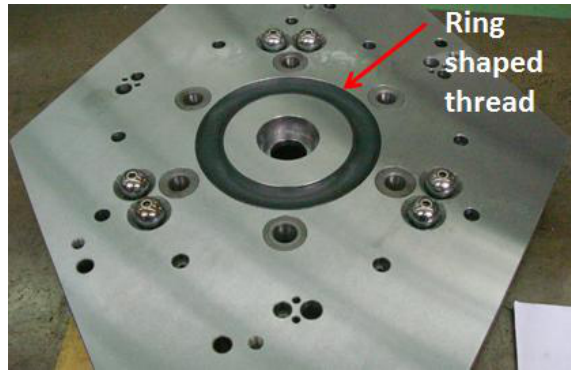
Figure 10. Ring shaped ring to ensure a rotational